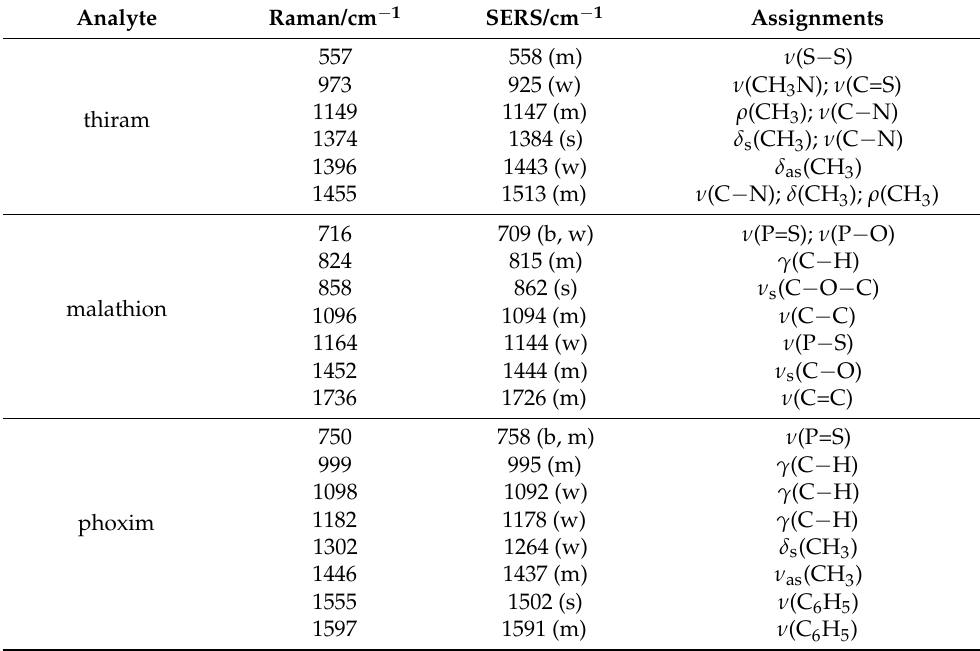
Table 1. Assignments of some characteristic bands in Raman and SERS spectra of three tested pesticides.